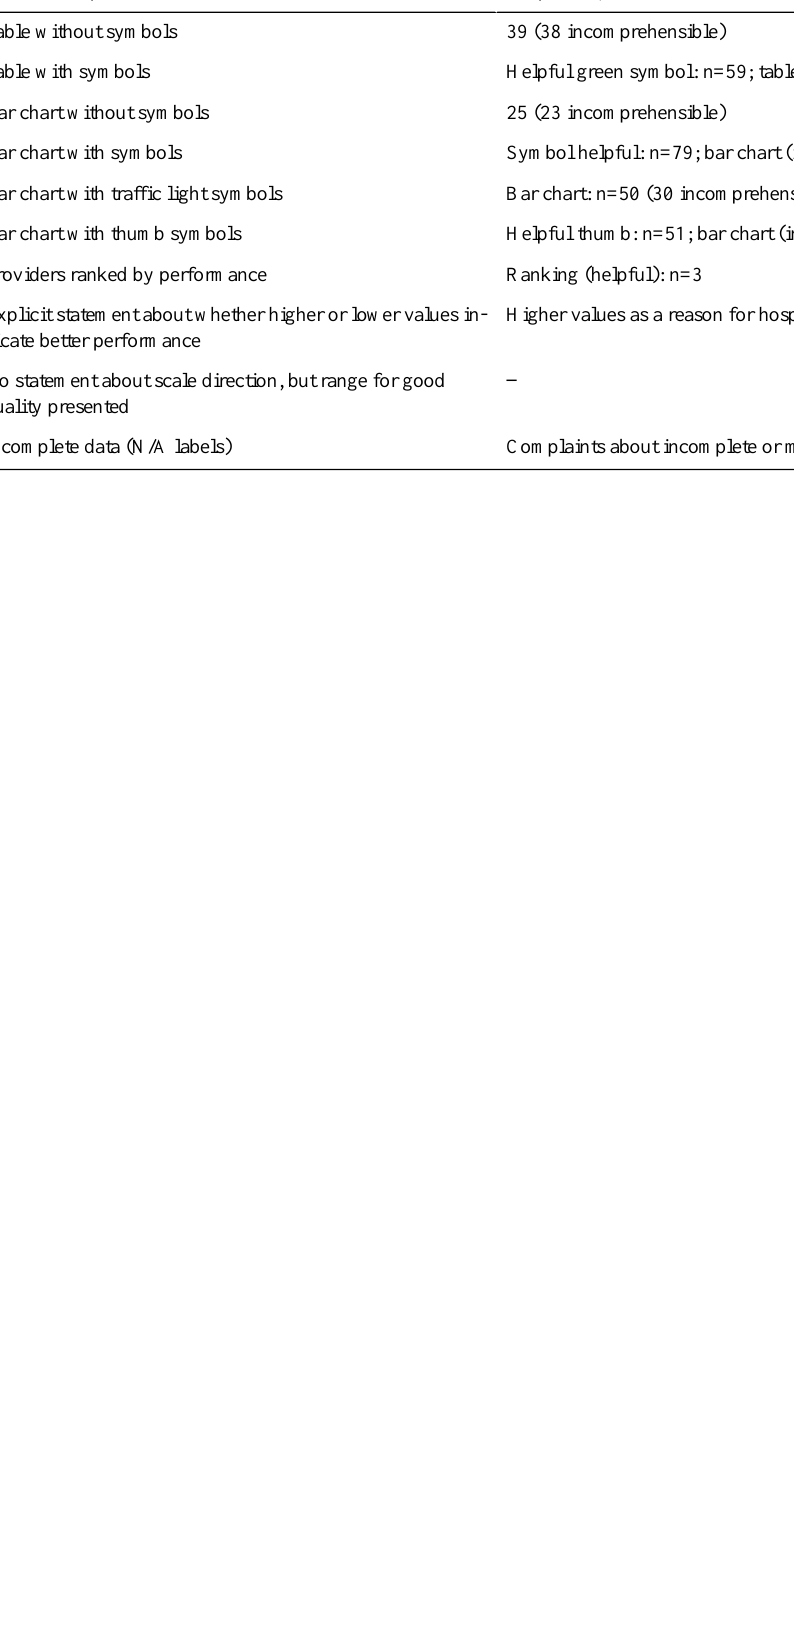
Responses, nInformation presentation